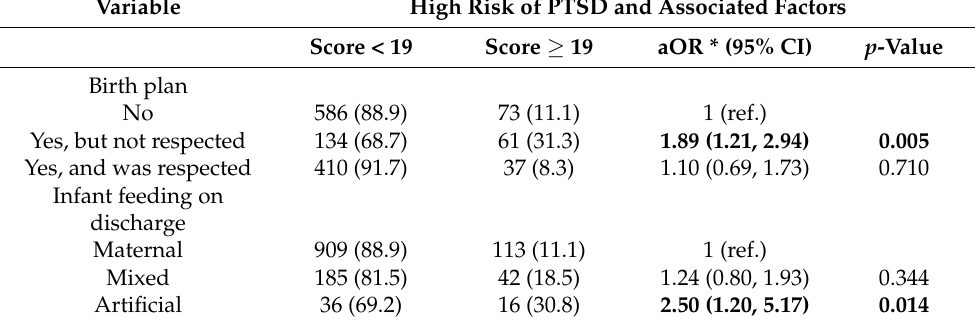
Table 3. Multivariate analysis between sociodemographic or obstetric characteristics and high risk of